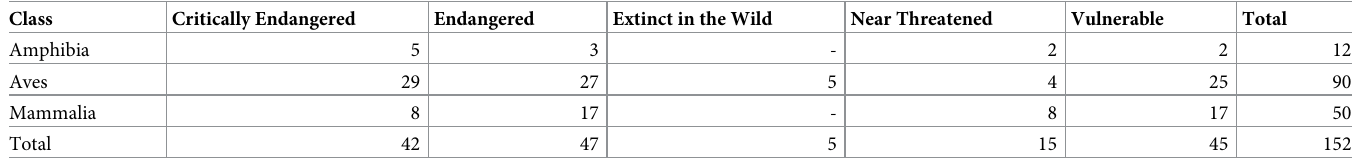
Table 1. Forest dependent threatened and Near Threatened species with CT as a recommended conservation action on the IUCN Red List. Class Critically Endangered Endangered Extinct in the Wild